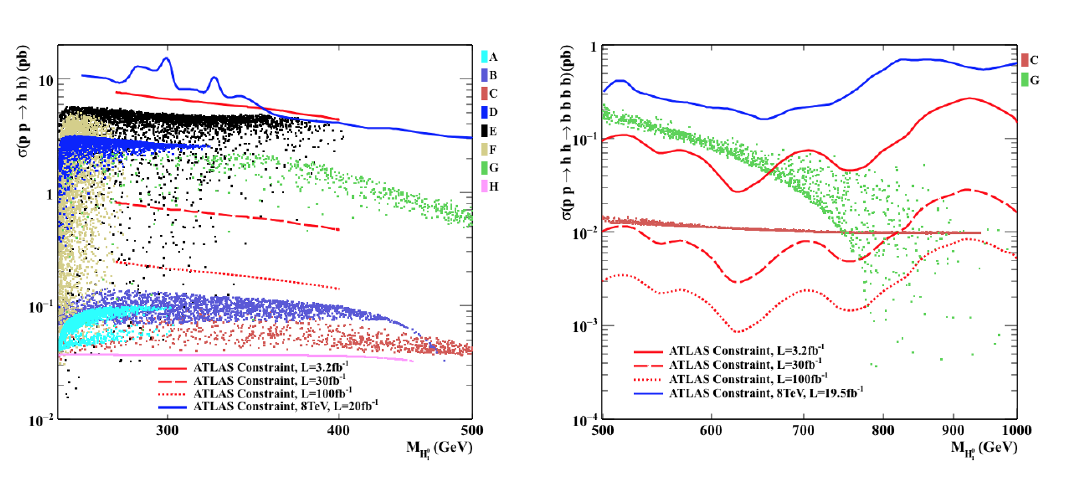
) (cid:2) (cid:20) 2 (cid:2) BR ( H 0 ! ! hh ) = (cid:27) ( pp ! H 0 1 1 1 F H 0 1